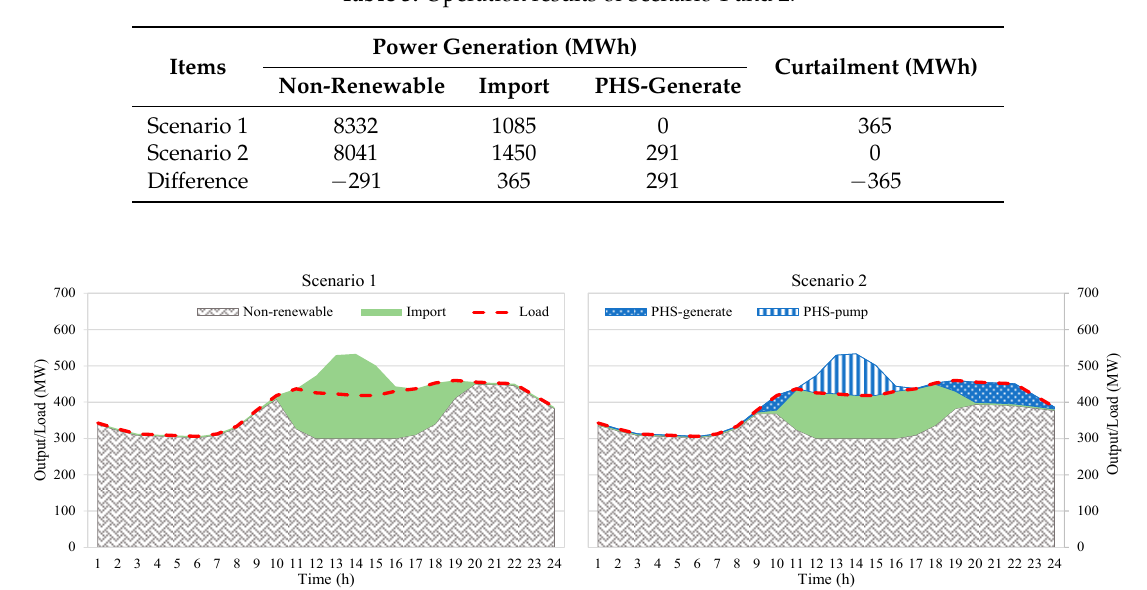
Figure 11. Operation process of the power stations in Area II.